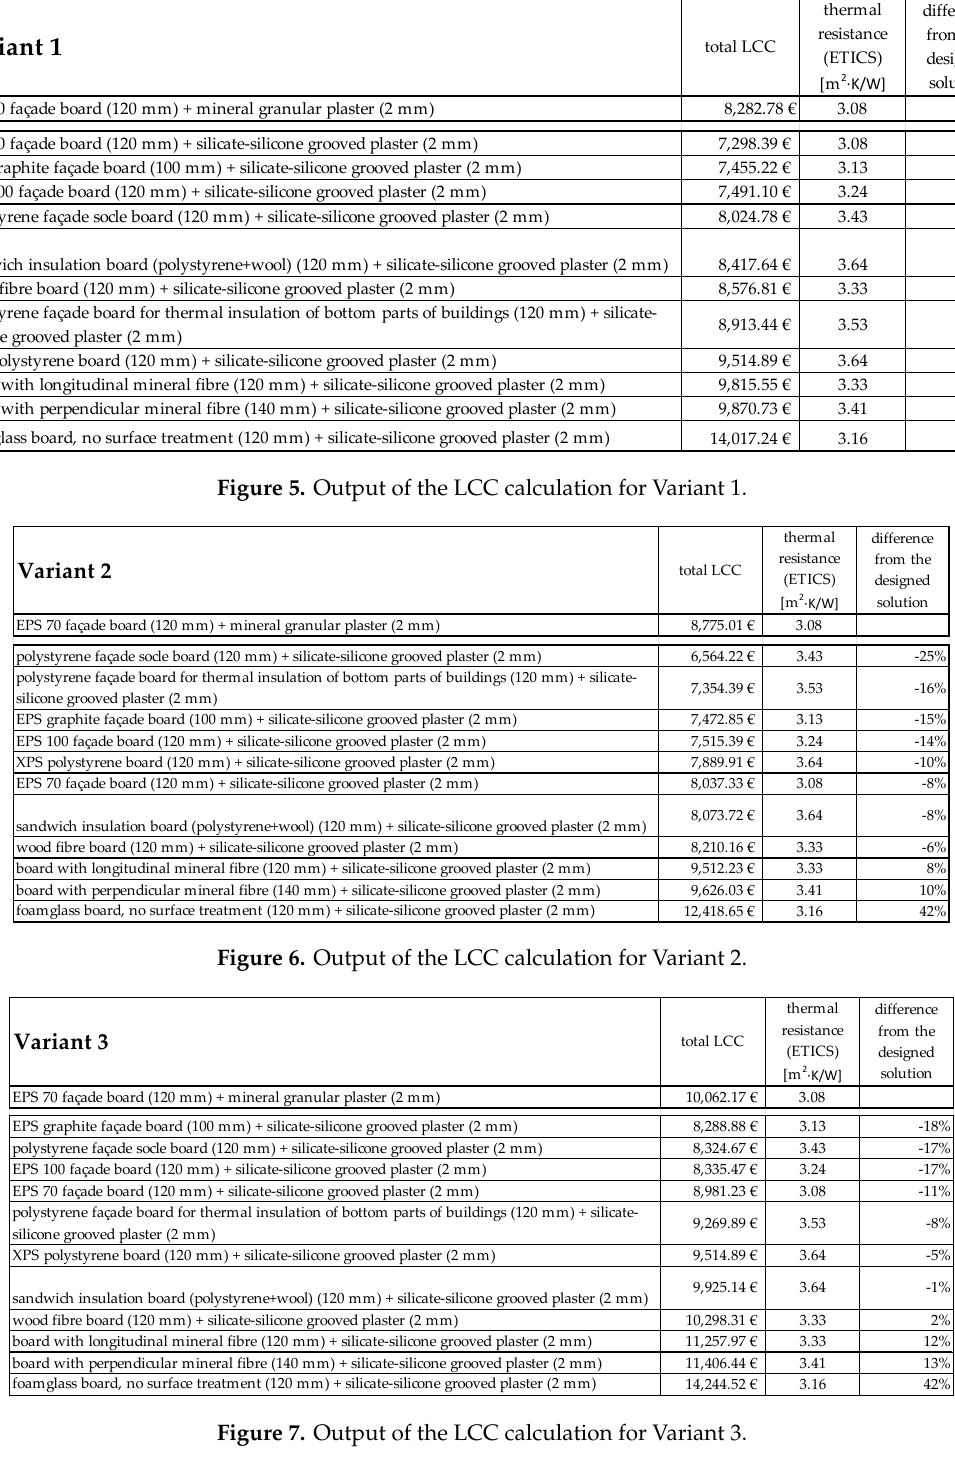
Figure 8. A showcase of information output transferrable to the BIM model.